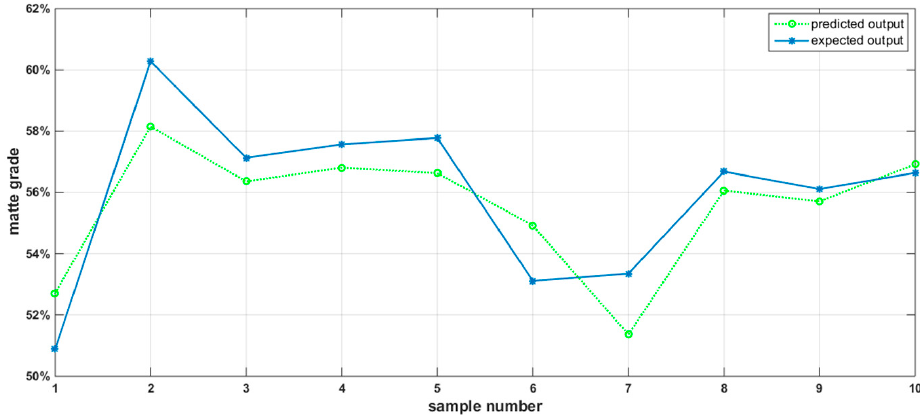
Figure 5. Chart of the test results of the BP neural network prediction model for ma tt e grade.